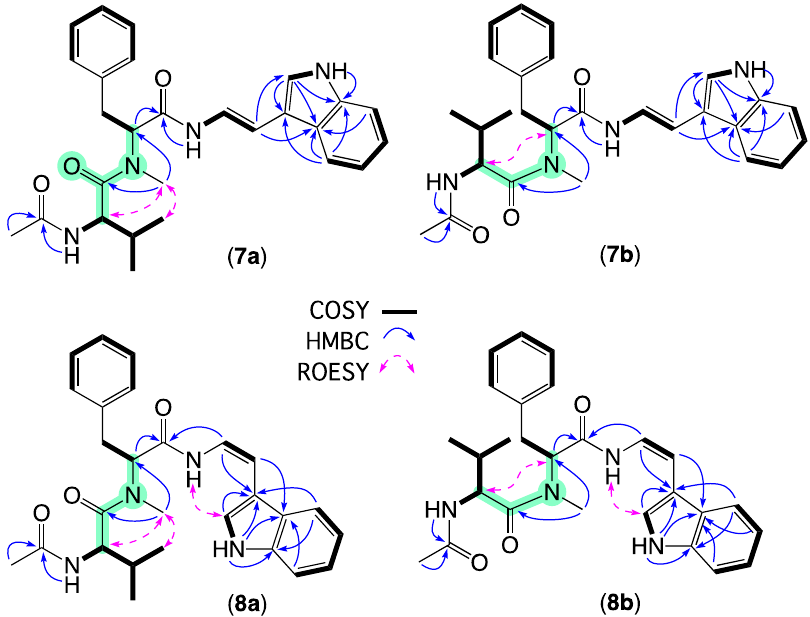
Figure 4. Selected 2D NMR (DMSO- d 6 ) correlations for equilibrating E ( 7a and 8a ) and Z ( 7b and 8b ) amide rotamers of aspergillamides E–F ( 7 – 8